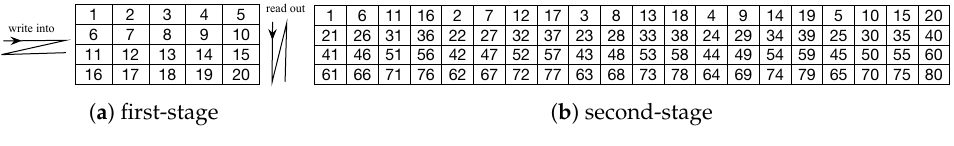
Figure 3. Two-stage block